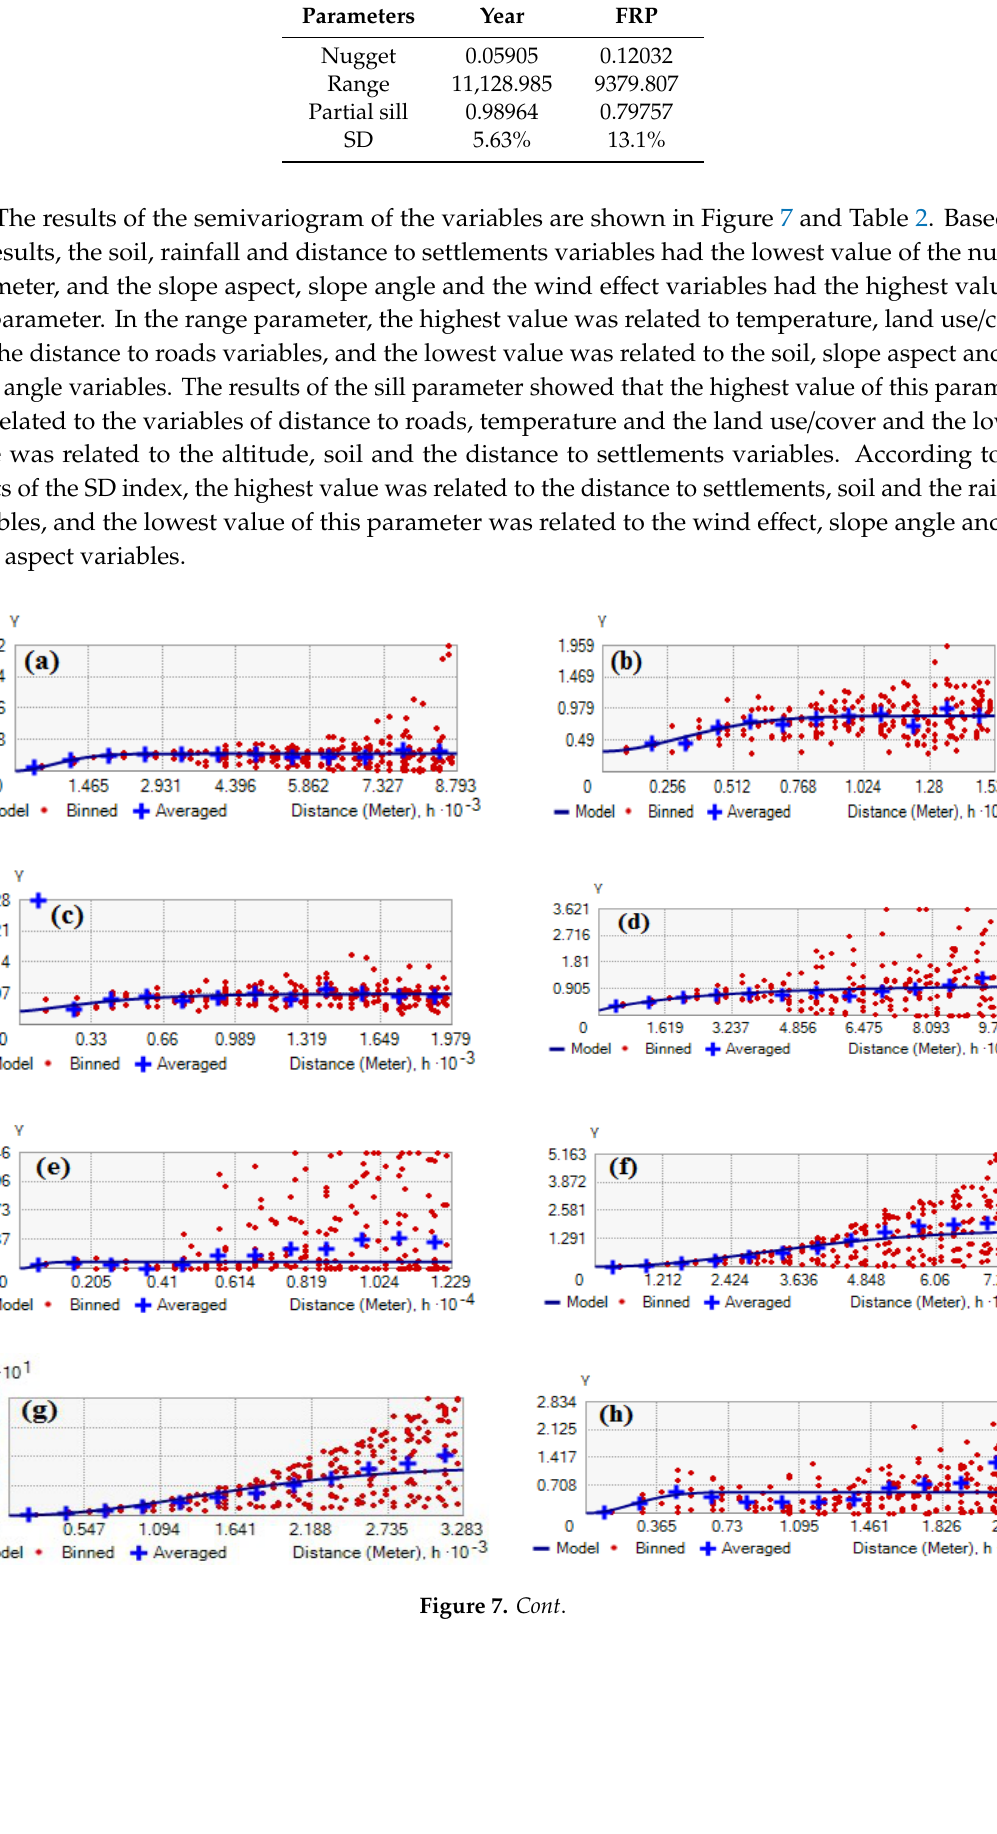
Table 1. Result of the semivariogram